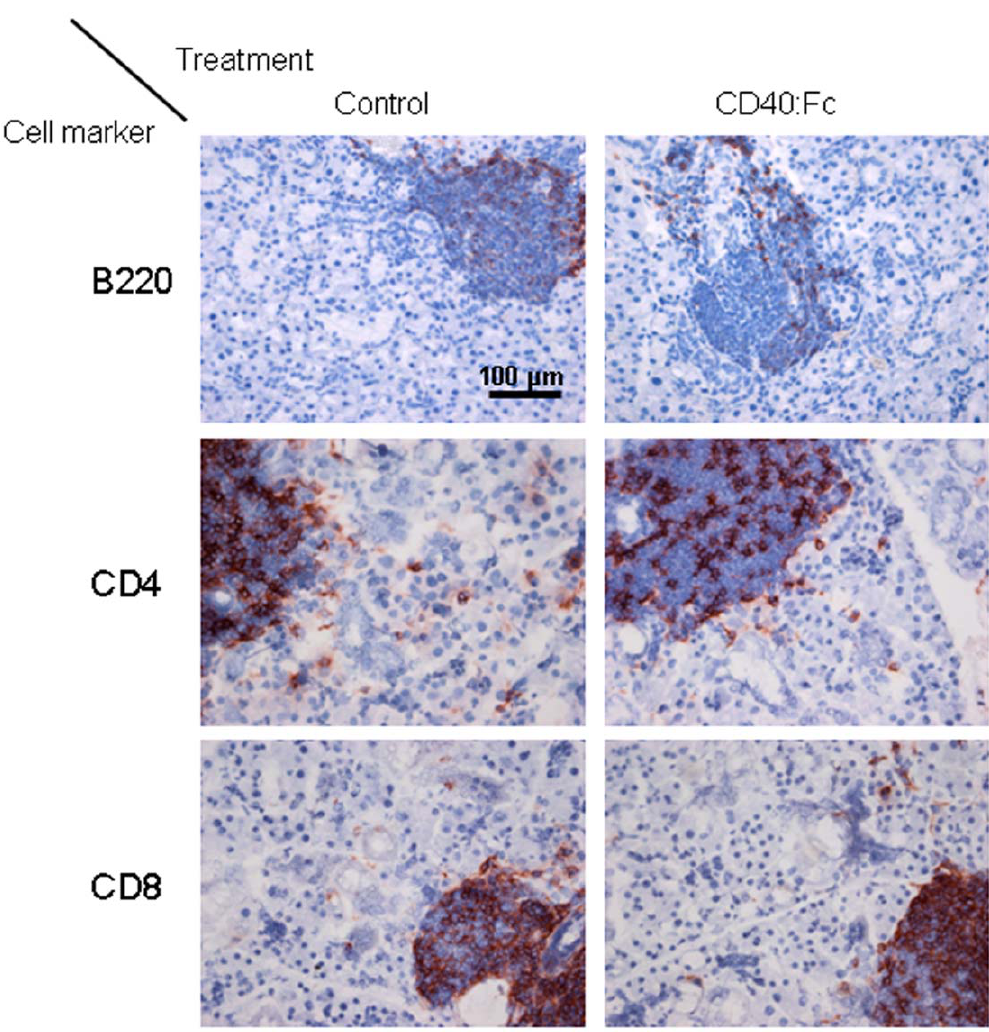
Figure 4. T and B cell presence in SG of 20 week old CD40:Fc or control treated NOD. Salivary gland (SG) tissue was cut in sections and stained with anti-CD4, anti-CD8 and anti-B220 antibodies. Representative photos (group n=8 mice each) of mice treated at 10 weeks are shown at the end of the study at 20 weeks. B220 + =B cells, CD4 + =Th cells and CD8 + =cytotoxic T cells.